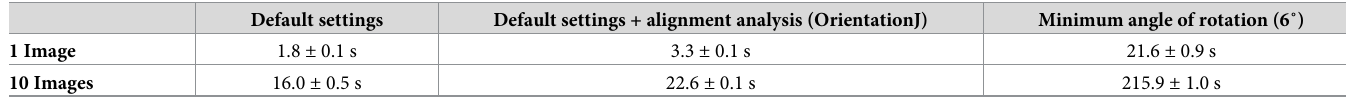
Table 2. GIFT macro processing time under different